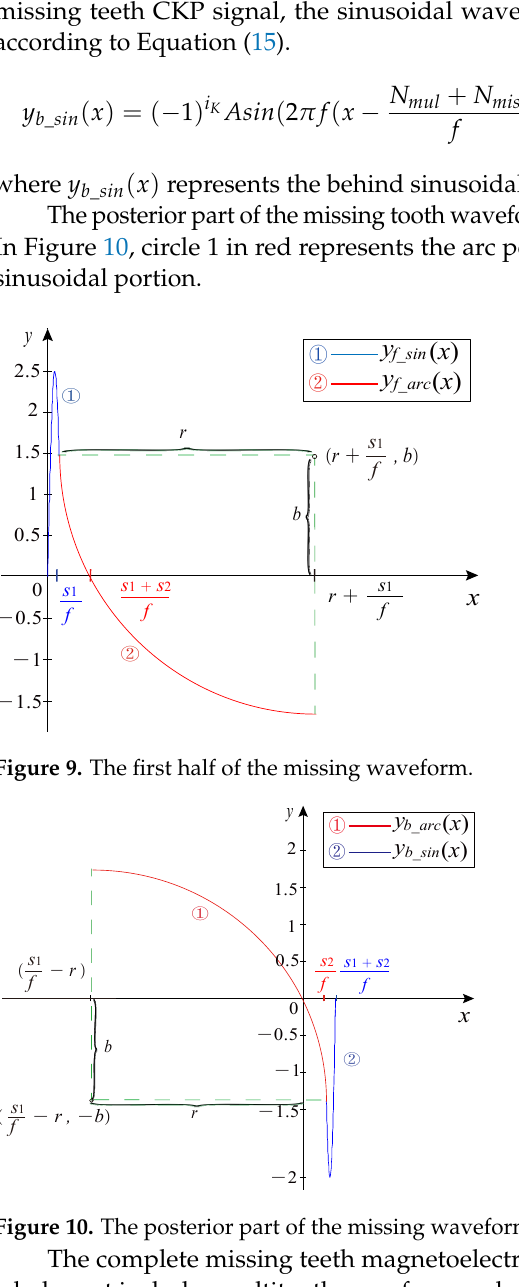
Figure 10. The posterior part of the missing waveform. The complete missing teeth magnetoelectric CKP signal is shown in Figure 11. The whole part includes multitooth waveform and missing tooth